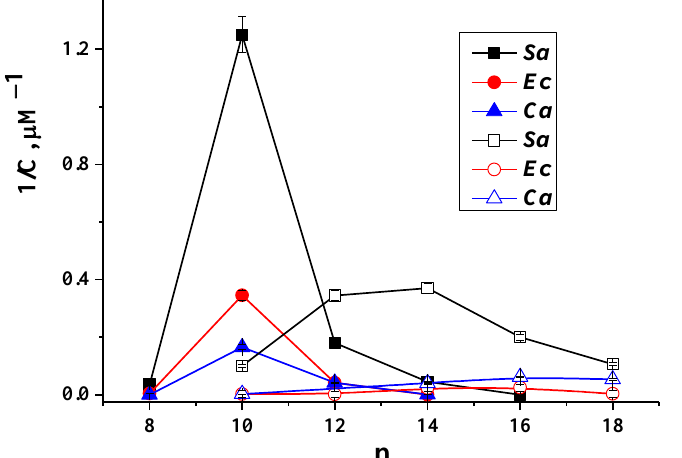
Figure 2. The dependence of the antibacterial activity 1/C, where C-MIC of S. aureus , E. coli, C. albicans on the length of the alkyl tail of mono-and dicationic surfactants of the series n-s-n (Im) (shaded symbols) and Im-n (empty